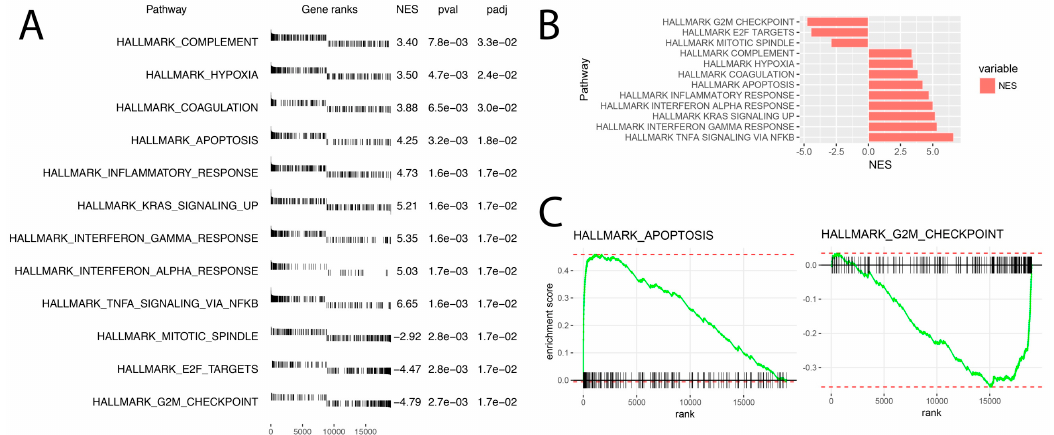
Figure 4. Gene set enrichment analysis using Hallmark gene sets. ( A ) List of significantly enrichment gene sets with appropriate gene ranks, normalized enrichment score (NES), p values (pval) and p values after FDR correction (padj). ( B ) Bar chart of normalized enrichment score (NES) values for previously selected gene sets. ( C ) Enrichment plot of “Hallmark apoptosis” and “Hallmark G2M checkpoint” gene sets.